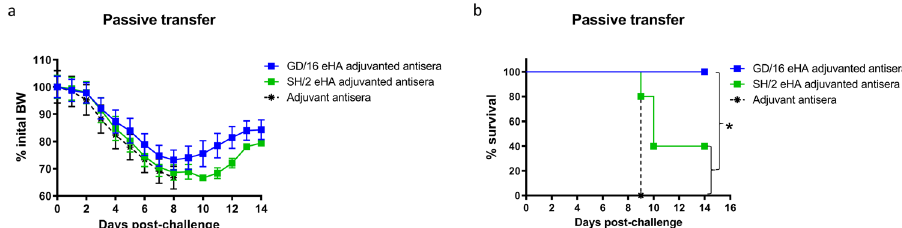
Fig. 4 Passive transfer of hyperimmune sera against lethal H7N9 challenge. Hyperimmune sera were collected from mice immunized with HA extracted (eHA) from H7N9 A/Shanghai/2/2013 (SH/2) or A/Guangdong/17SF003/2016 (GD/16) at 500 ng/mouse with adjuvant. Pooled hyperimmune sera were injected intravenously into naïve mice followed by a lethal challenge of GD/16 IDCDC-56N virus. ( a ) Body weight (BW) and ( b ) survival after GD/16 IDCDC-56N challenge. BW data are expressed as mean ± s.e.m ( n = 5 mice/group). * p < 0.05 by Log-rank (Mantel – Cox) test (survival curves).